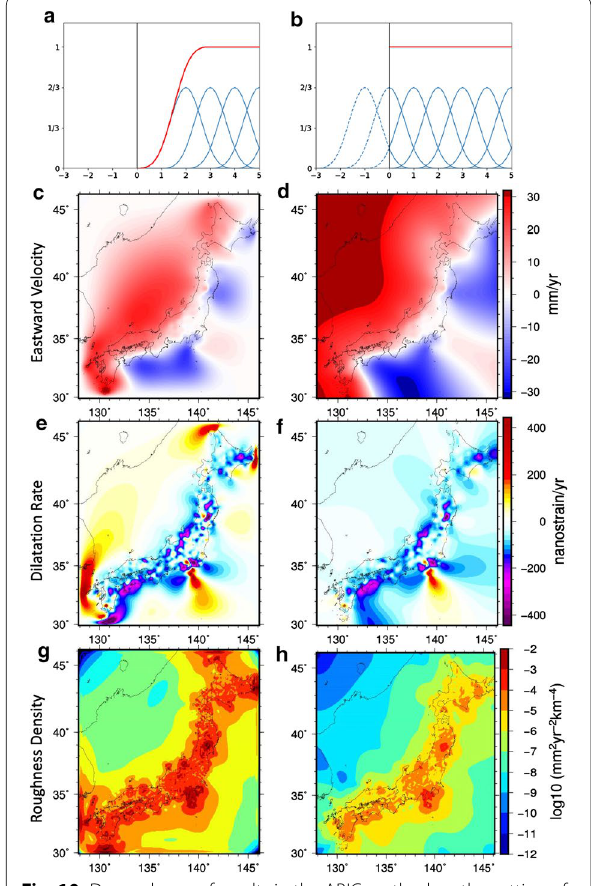
Fig. 10 Dependence of results in the ABIC method on the setting of basis functions at the model boundary. a , b Setting of basis functions. Blue curves represent individual cubic B-splines, and the red curve represents their summation. The vertical line indicates the boundary of the analysis region. Basis functions are truncated at the boundary in b . c , d Estimated eastward velocity fields using basis functions shown in a and b , respectively. e , f Estimated dilatation-rate fields using basis functions shown in a and b , respectively. g , h Spatial distribution of roughness density using basis functions shown in a and b , respectively